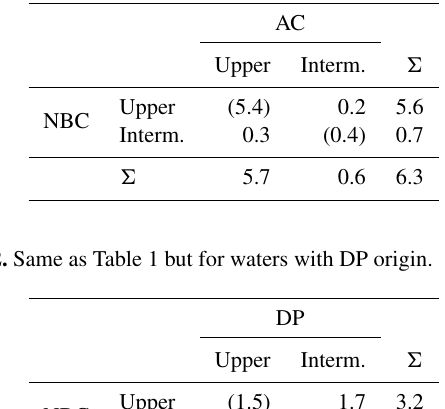
Table 1. Net water mass transformation of upper and intermediate waters with AC origin between their entry into the South Atlantic and arrival in the NBC in Sverdrups; water volumes without any net transformation into the other class are listed in brackets.